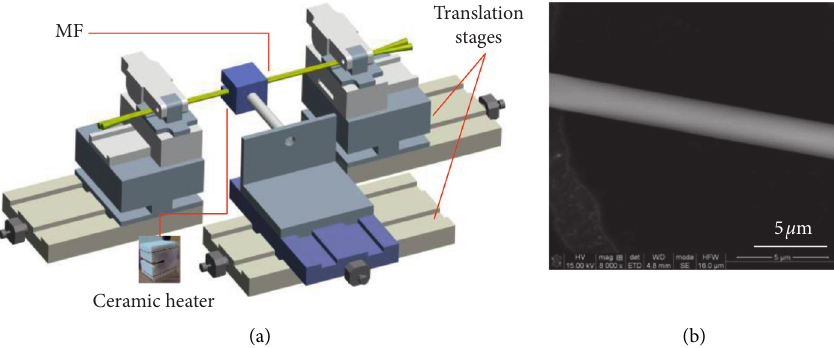
Figure 1: (a) Microfiber fabrication setup; (b) the SEM image of the waist region of prepared microfiber. The diameter of each fused microfiber is about 2 μ m.